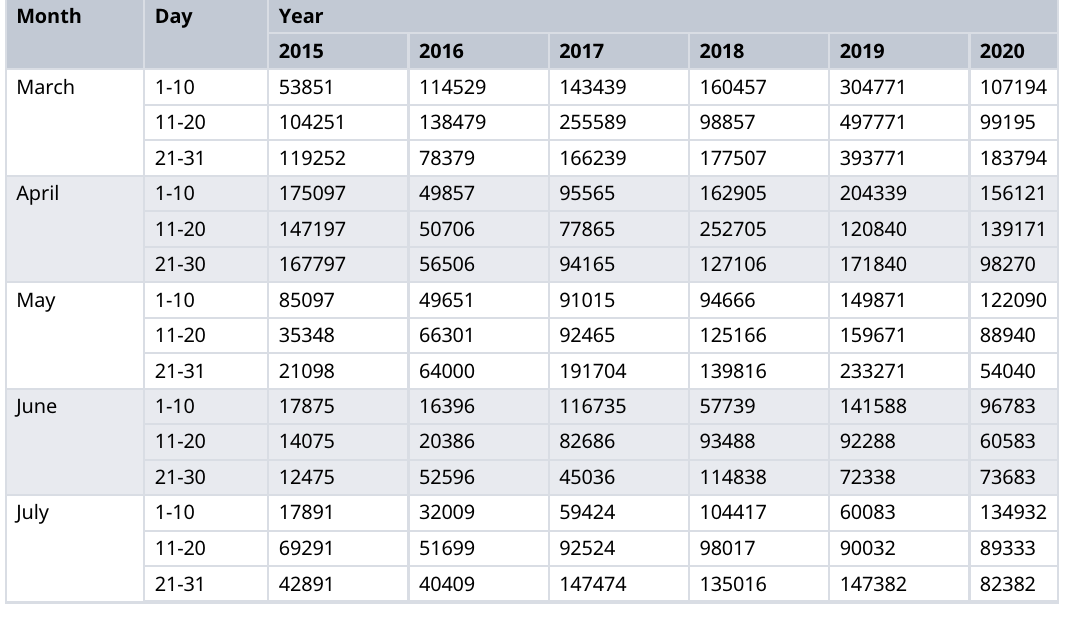
Table 2. LSC in Oceania (2015-2020).